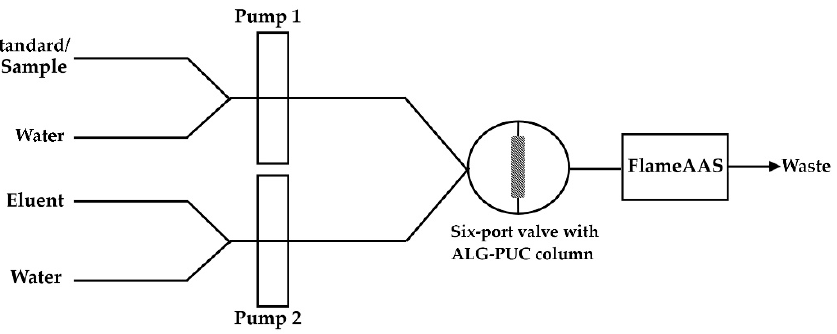
Figure 7. FI-FlameAAS system .